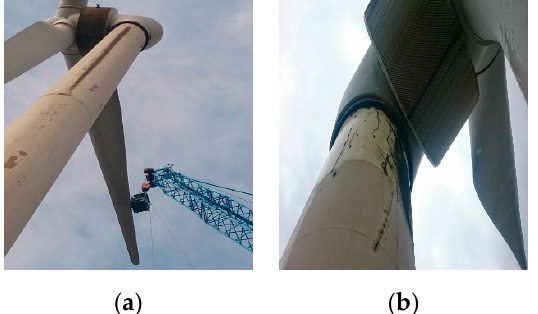
Figure 1. Wind turbine physical problems: ( a ) moistness and dust; ( b ) grease and hydraulic oil